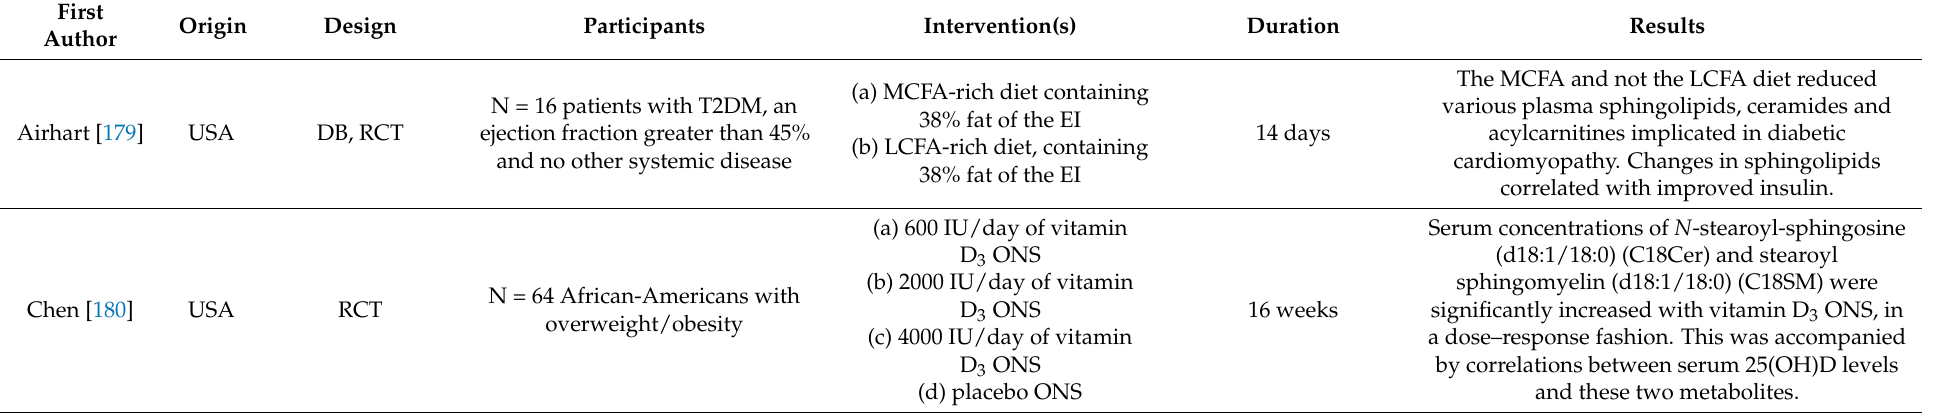
Table 9. Randomized clinical trials administering dietary interventions to improve ceramide concentrations in